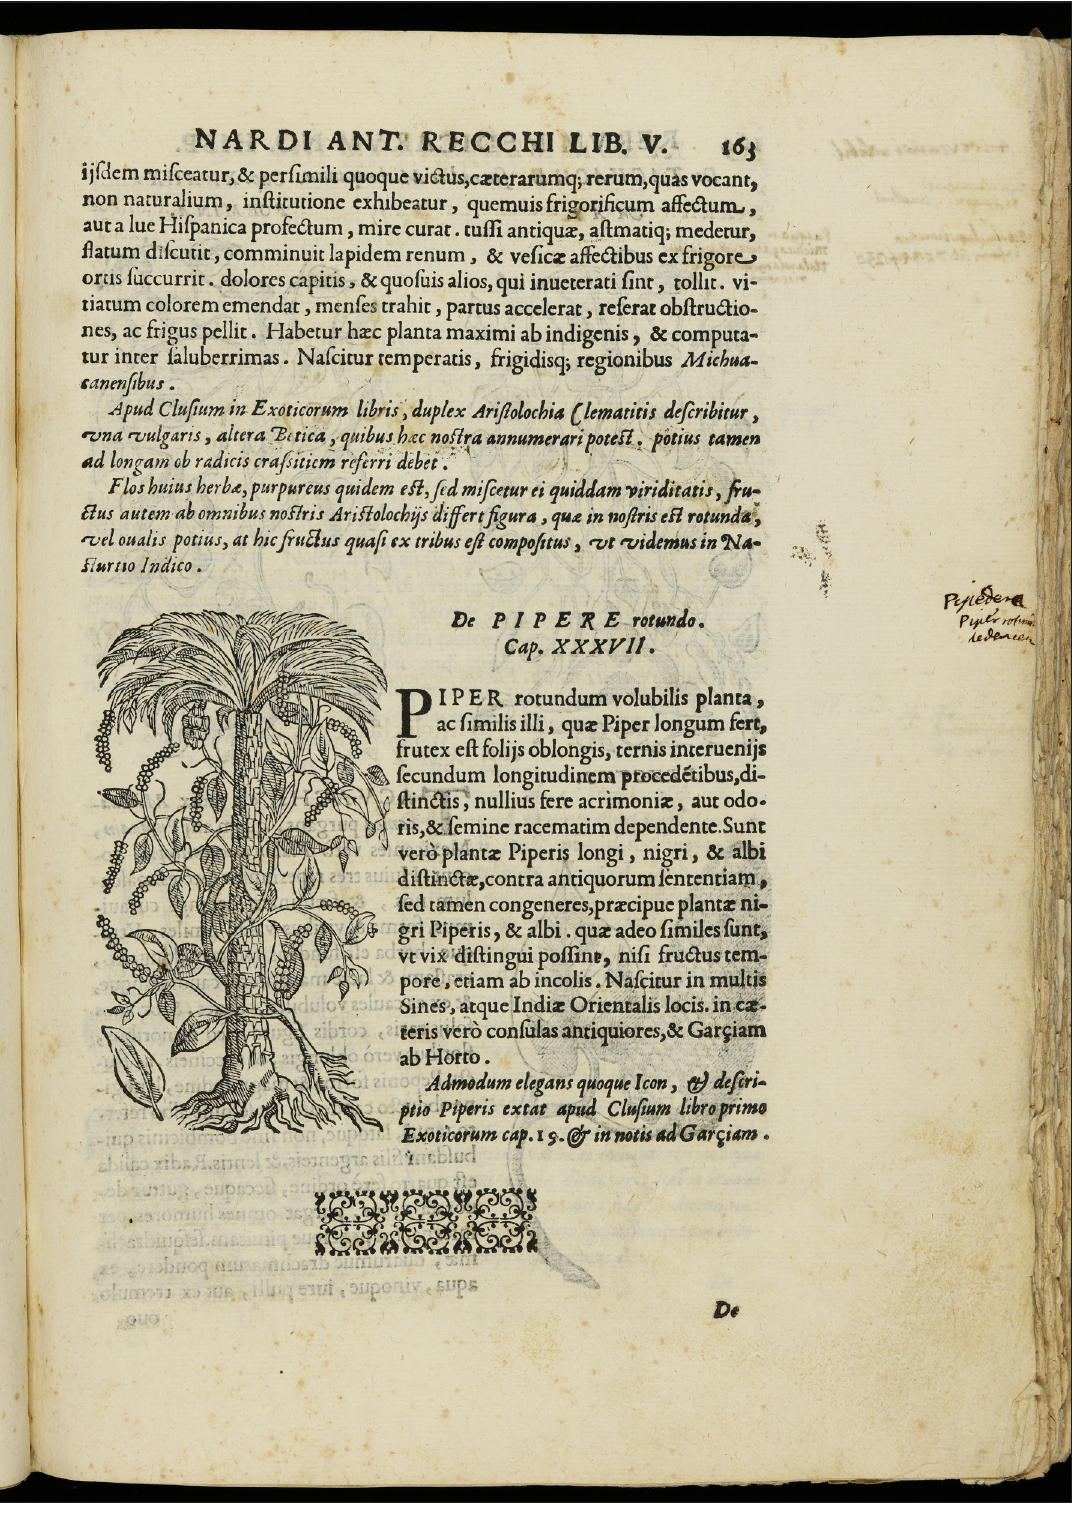
Figure 6: Description and woodcut of the Pipere rotundo from Hernández et al., Rerum medicarum 1648– 1651, 163 (by permission of the Accademia Nazionale dei